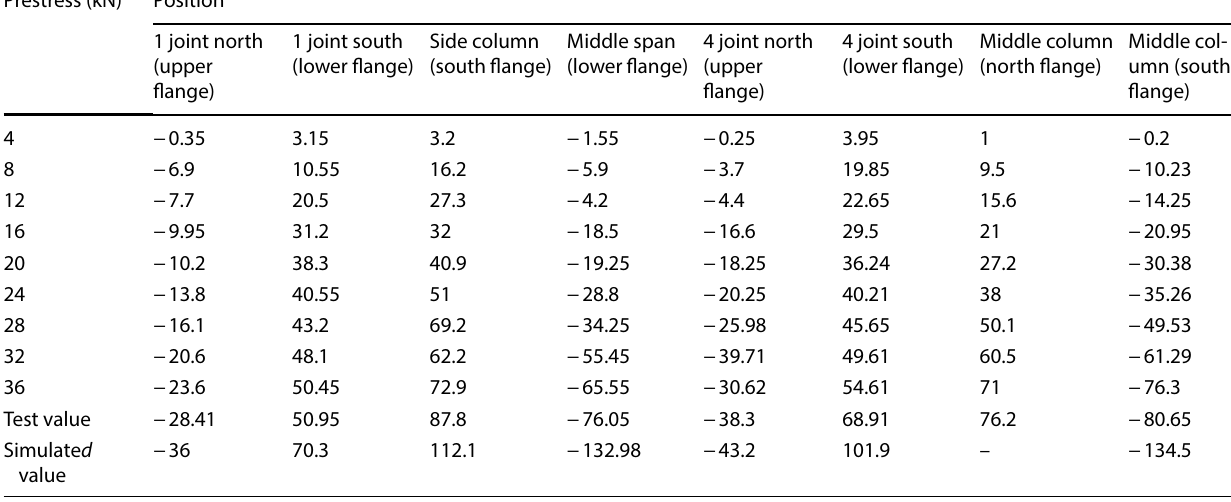
Fig. 23 Micro strain compari- son